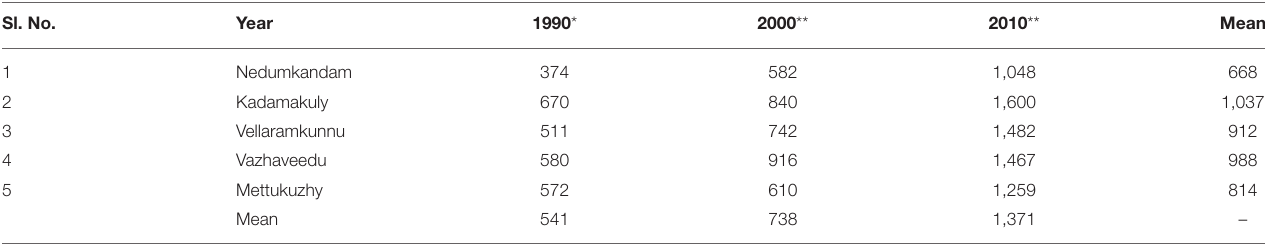
TABLE 1 | Yield of cardamom (cured) from the CHR cardamom hotspots (g plant − 1 ). Sl.